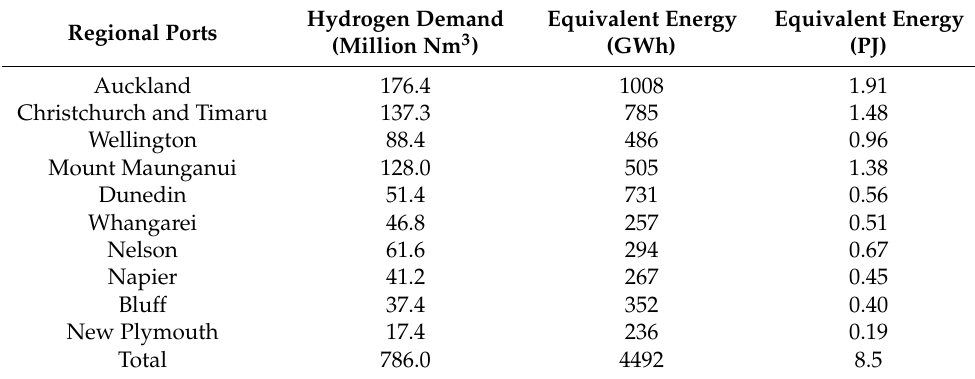
Table 2. Estimated annual (2017) electrolytic energy consumption per region.